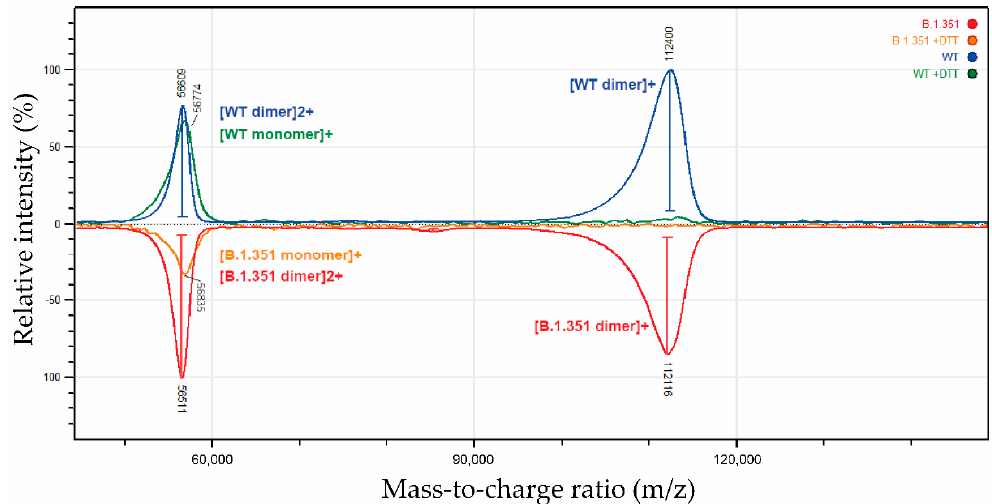
Figure 7. Intact mass analysis of WT and B.1.351 RBDmfc proteins by MALDI-TOF. Intact mass of non-deglycosylated RBDmfc proteins was determined on secreted WT and B.1.351 RBDmfc recombinant proteins, as well as on their DTT-reduced counterparts. The mass-to-charge ratio ( m / z ) was plotted against the relative abundance of fragment ions (relative intensity [%]) for WT (top panel, blue and green) and B.1.351 (bottom panel, red and orange) RBDmfc proteins. Doubly charged ions (marked “2+“, compared to singly charged ions marked “+“) appear at “half mass“. Mass spectrometry confirmed the homogeneity in molar mass characterised by HIC-MALS (Figure 6) and by SEC (Figure 8) for WT and B.1.351 RBDmfc proteins.